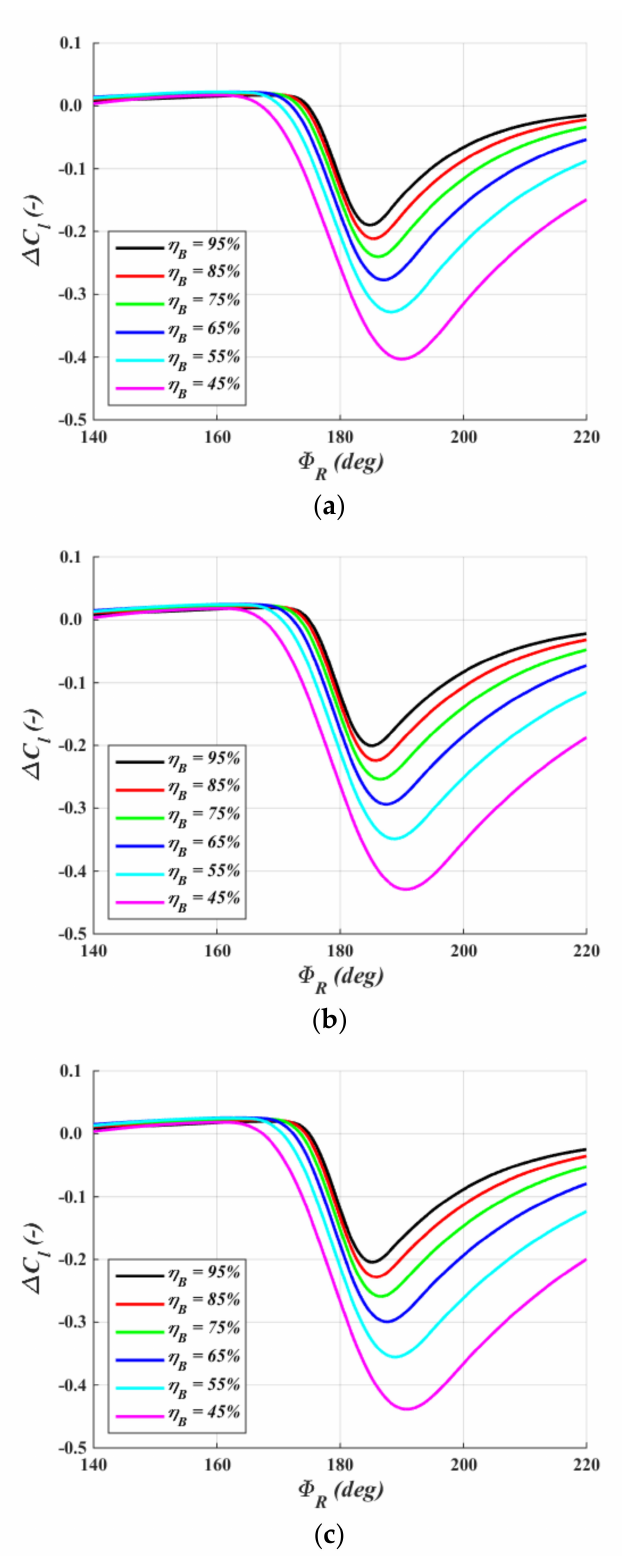
Figure 5. Deviations in wind speed of the rotor plane and the lift coe ffi cient according to the present method with the present threshold: ( a ) Case 1: V T = 36.0 m / s; ( b ) Case 2: V T = 44.1 m / s; ( c ) Case 3: V T = 46.7 m /